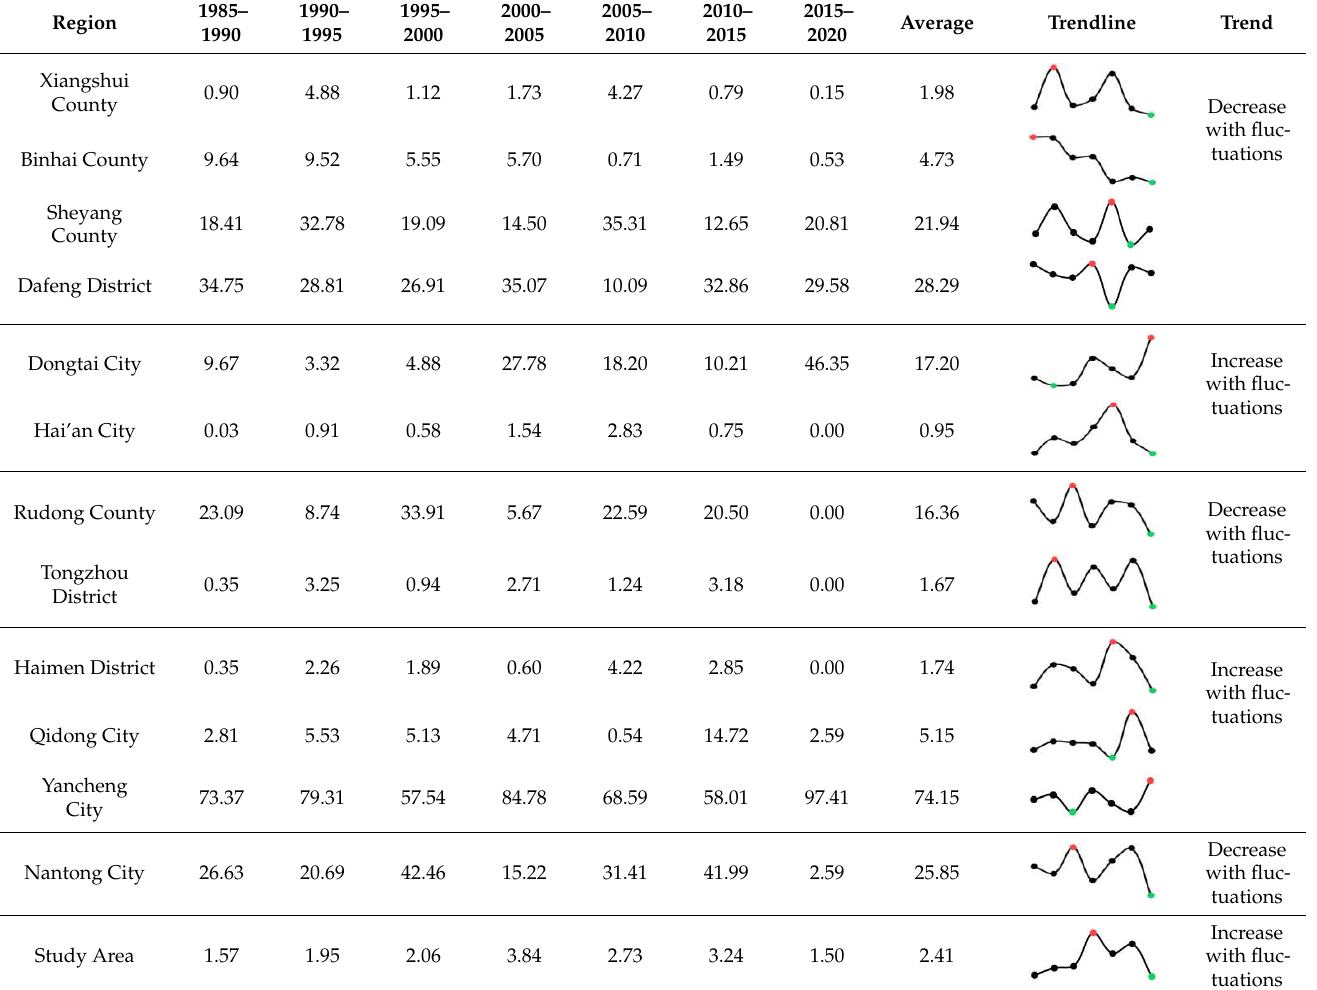
Note: The last row of values indicates the proportion of area with an improving degradation level compared to the total area of the study area.